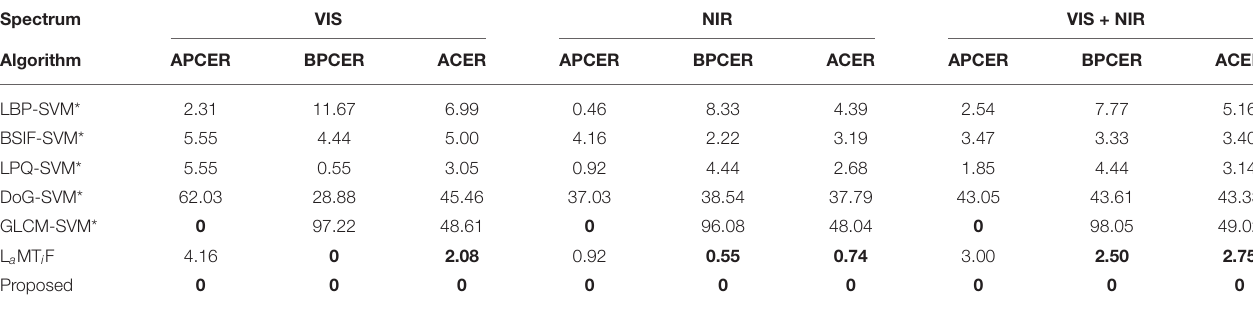
TABLE 3 | Results (%) on individual and combined spectrum set of MSSPOOF